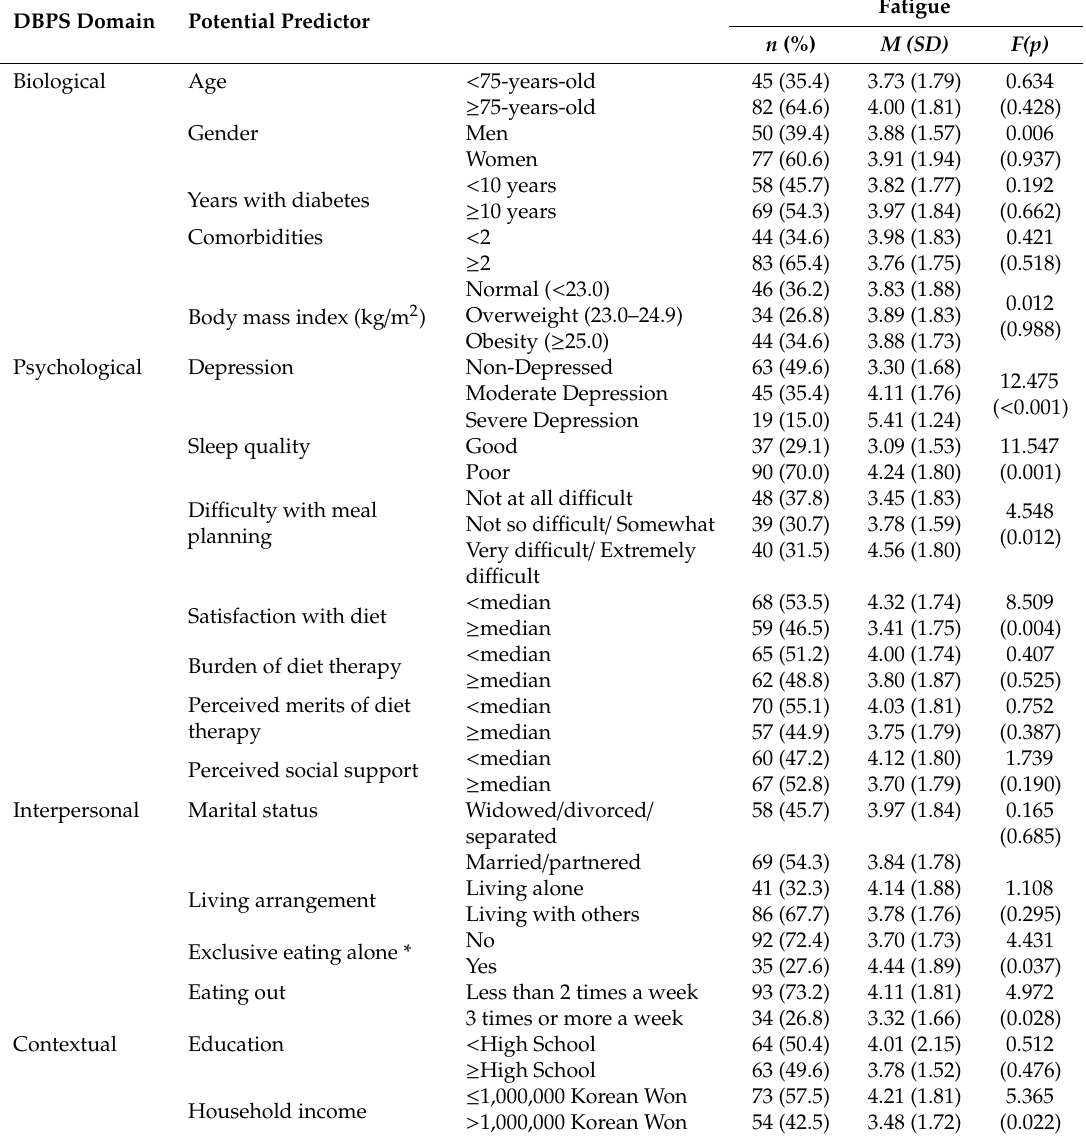
Table A1. The severity of fatigue according to four domains of the DBPS